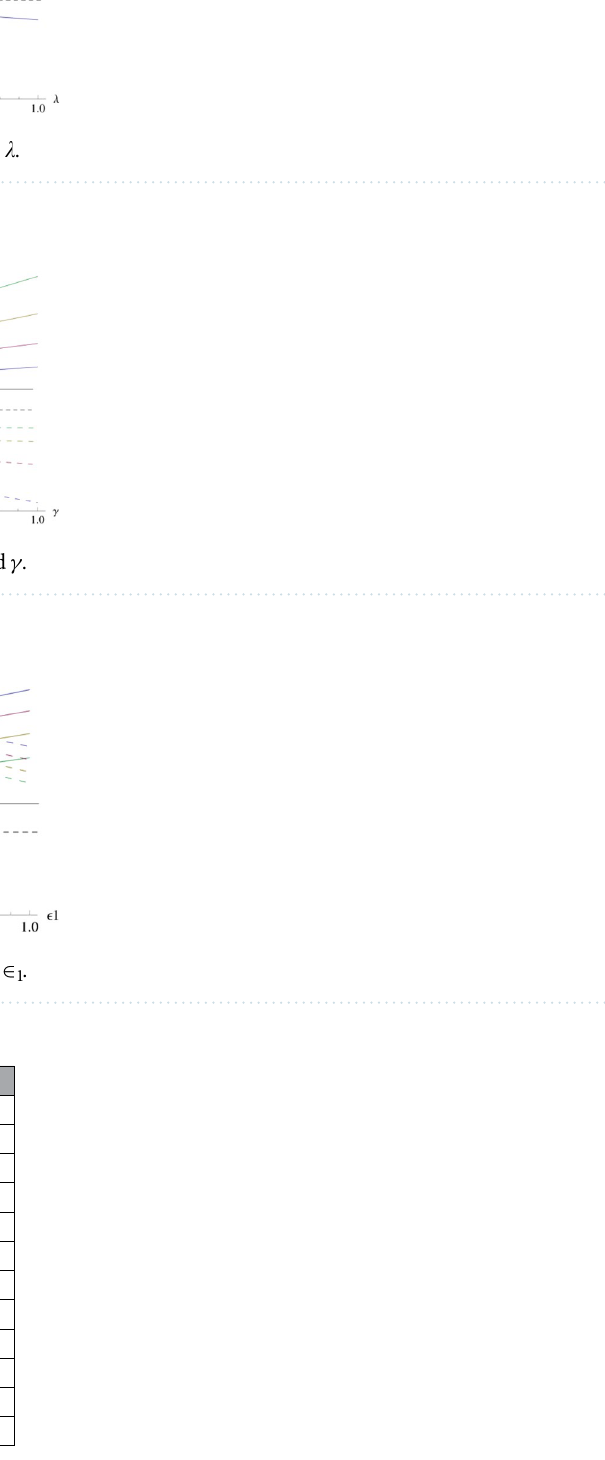
Table 1. Values of Coefficient of Skin friction ( Cf ) for diverse values of Re, (cid:31) and (cid:31) 1